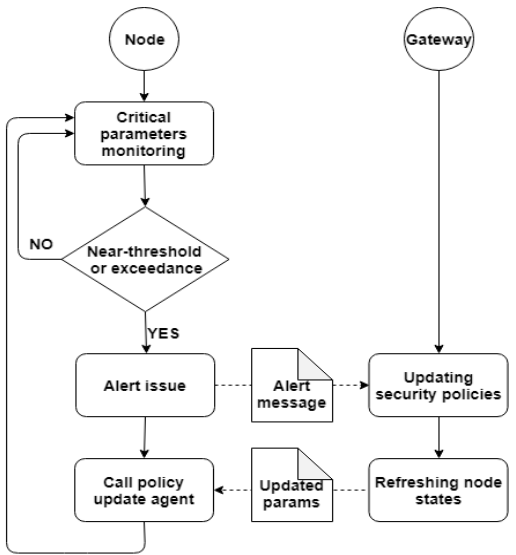
Figure 7. The architecture of the Node Status Monitoring Module.